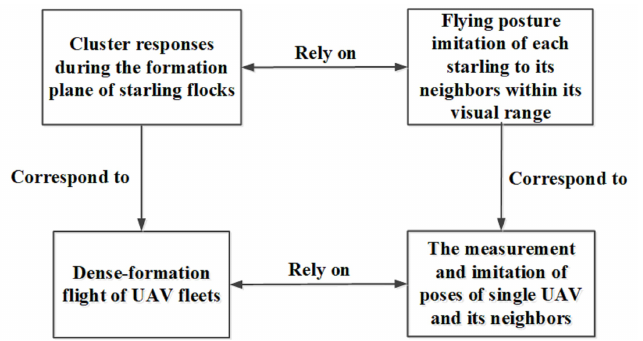
Figure 4. Compared architecture between starling flocks and UAV fleets.